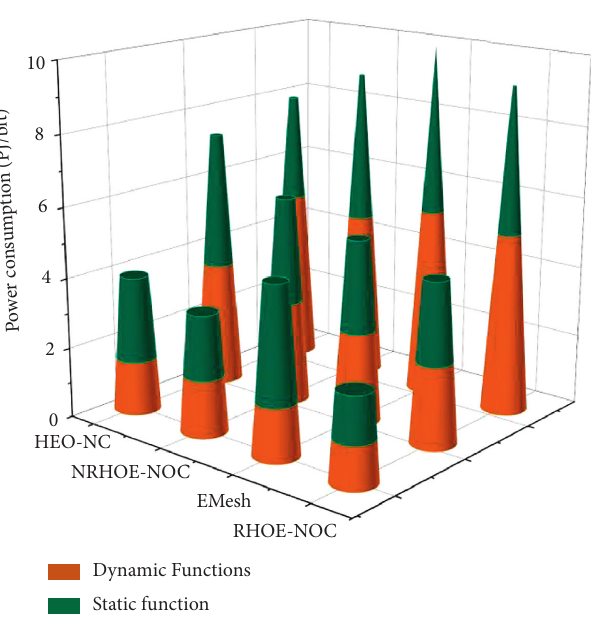
Figure 6: Power consumption composition